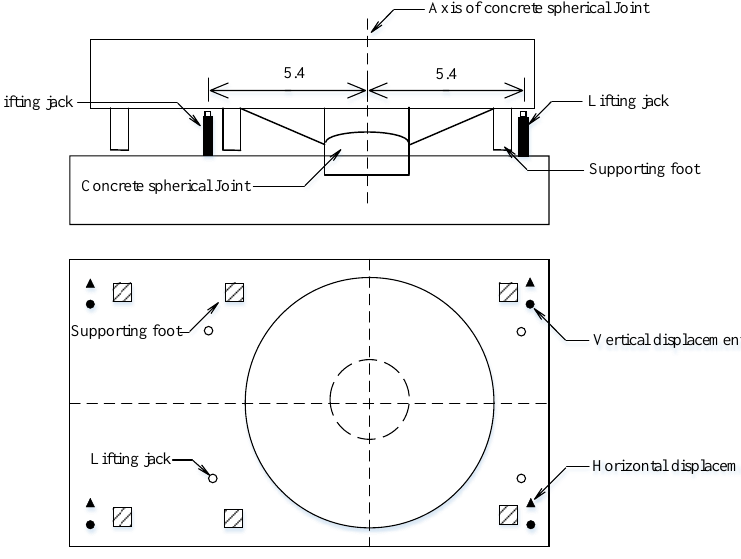
Figure 11. ( a ) Lifting system; ( b ) displacement sensors.